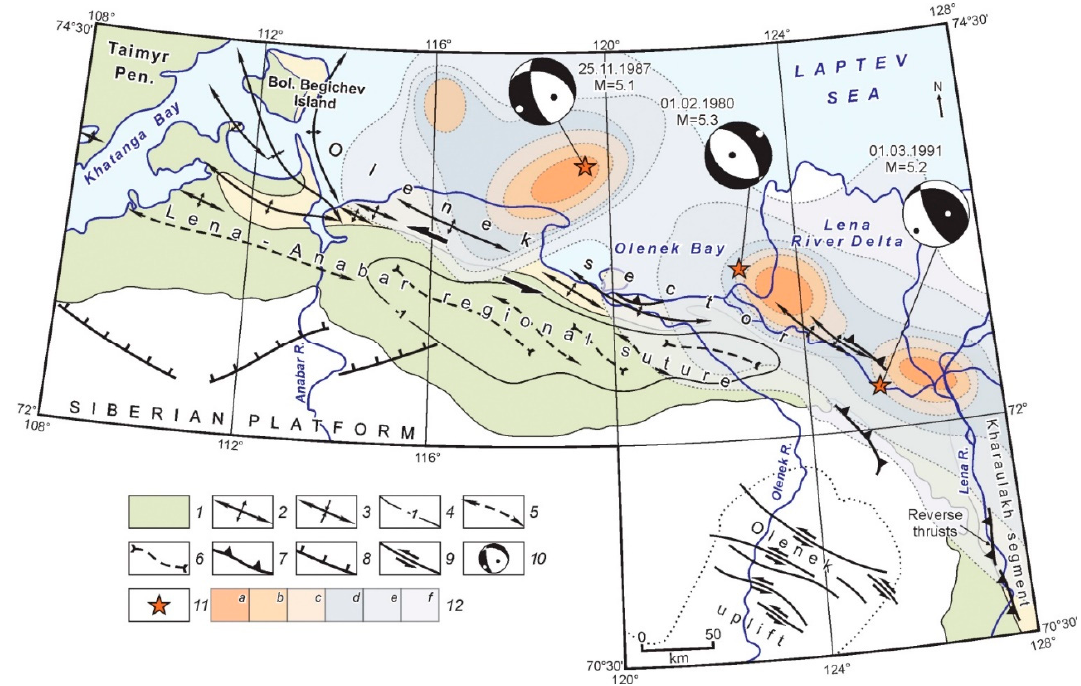
Figure 3. Seismotectonics of the Olenek sector of the Lena–Anabar regional suture (modified after [7]). 1—Lower Cretaceous continental deposits; 2—anticline axis; 3—syncline axis; 4—isoheights of the Lower Cretaceous bottom; 5—axis of consedimental bar; 6—axis of consedimental basin; 7–9—kinematics of active faults: 7—thrust, 8—normal fault, 9—strike-slip fault; 10—focal mechanisms, dates and magnitudes of earthquakes (lower hemisphere; the principal stress axes of compression and extension are marked by black and white dots, respectively); 11—earthquake epicenter; 12—density of earthquake epicenters (number of seismic events per 1° × 1°): ( а ) 26–30, (b) 21–25, (c) 16–20, (d) 11–15, (e) 6–10, (f) 1–5.